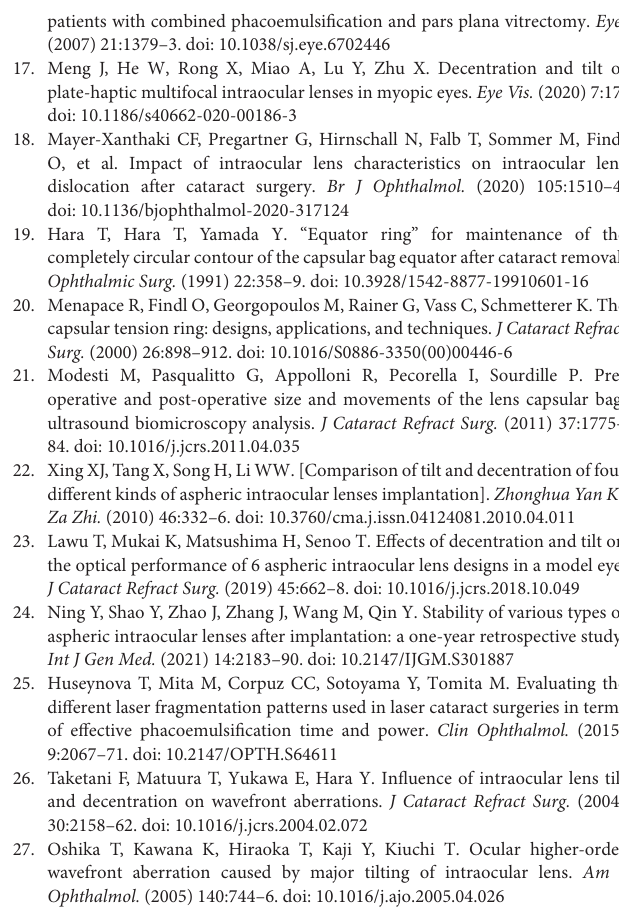
Supplementary Table 1 | The baseline data of Group A and Group B. Between the two groups, no statistically significant differences were found in age, sex, operated eye, AL, IOL power, pre-operative UDVA and CDVA (all P > 0.05).